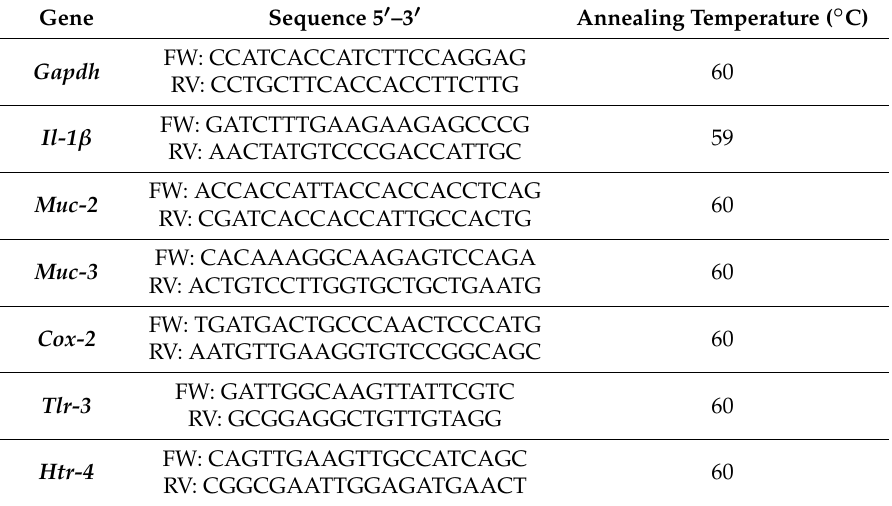
Table 1. Primer sequences used for real-time PCR